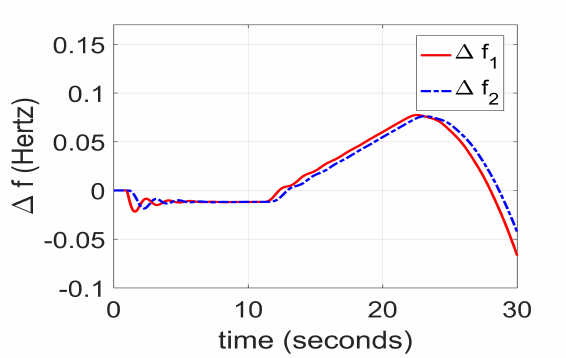
Figure 4. Frequency measurement under timing attack.